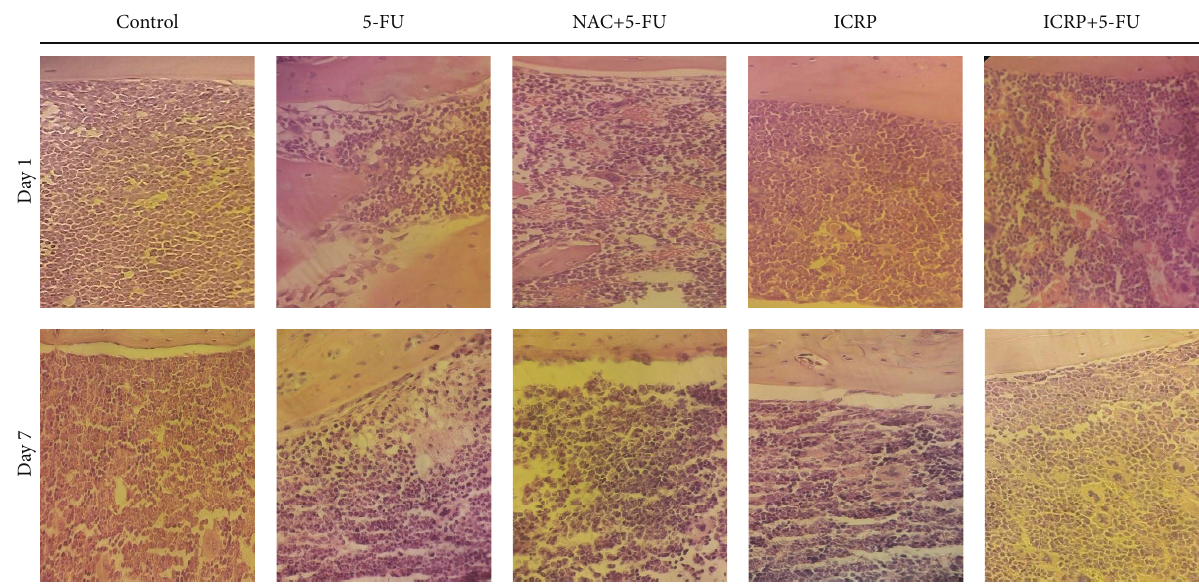
Figure 6: Bone marrow histology: on day 1 and day 7, femora of treated mice were harvested, fixed, sectioned, and stained with hematoxylin and eosin. The histological description was made by a pathologist; photographs were taken under a microscope at 40x.